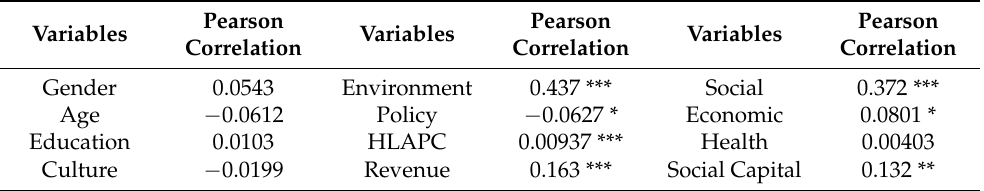
Table 4. Correlation between dependent and independent variables.